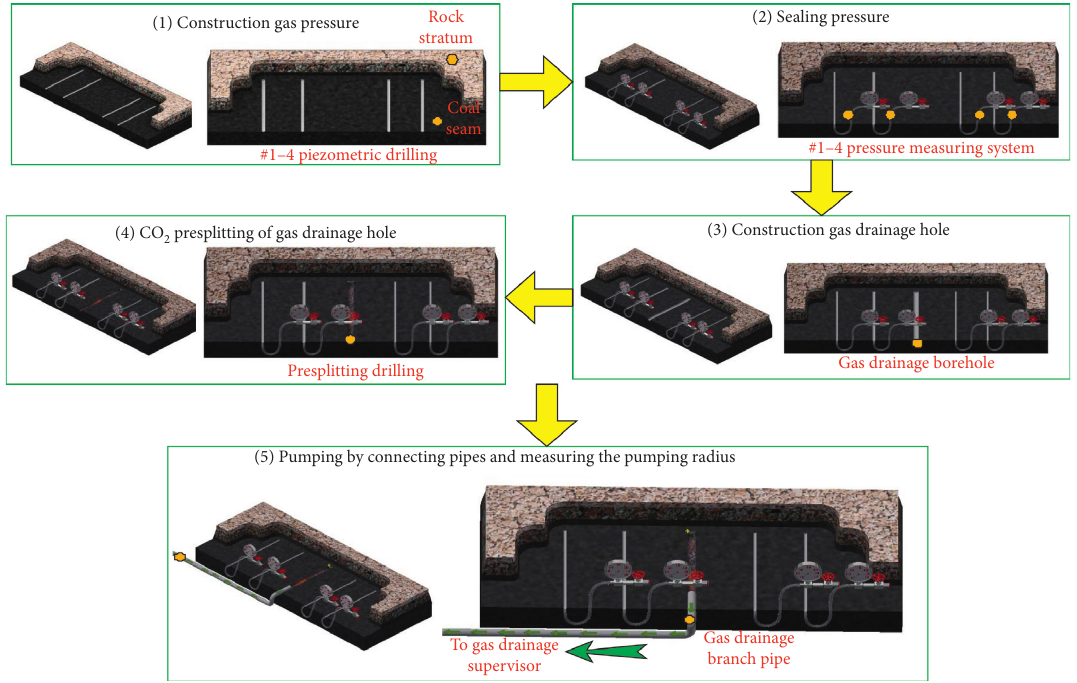
Figure 4: Field measurement process of the extraction